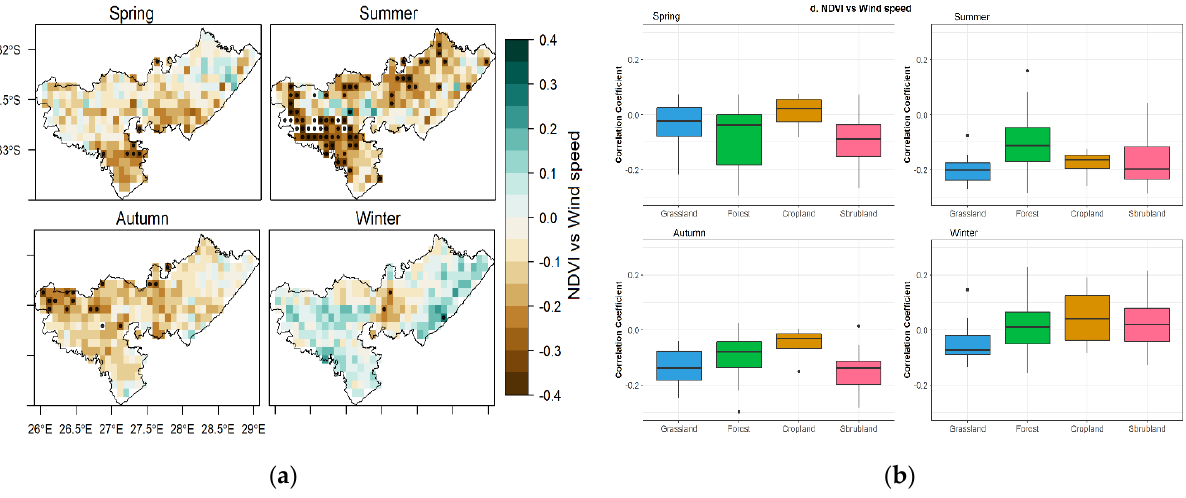
Figure 8. ( a ) Pixel-wise partial correlation coefficients between the NDVI3g and the ERA5-Land wind speed for Amathole District Municipality; and ( b ) boxplots of correlation for vegetation types. The stipplings are for pixels with statistical significance ( p -value < 0.05).